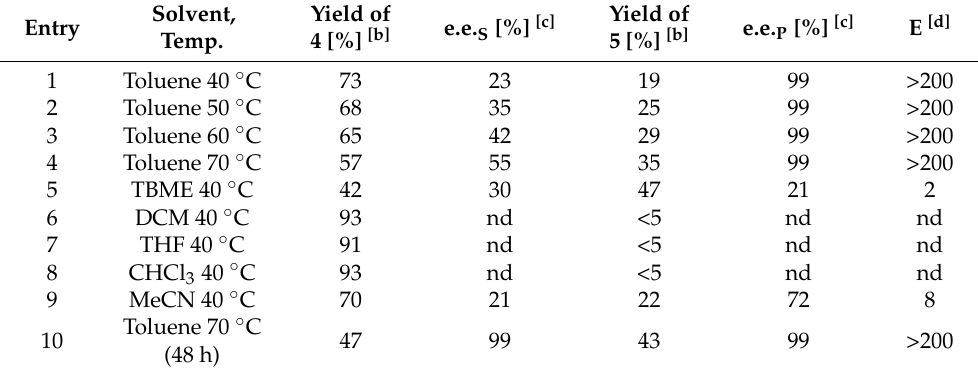
Table 2. The optimization study [a]